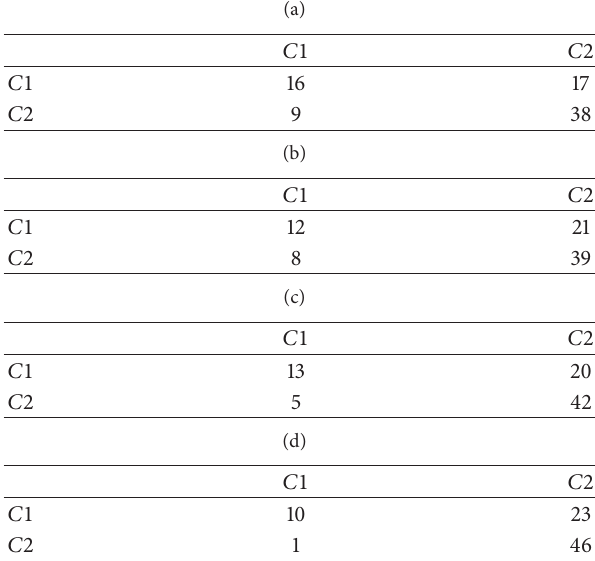
Table 11:Confusionmatrices of(a)Adaboost, (b)Bagging, (c)RSM, and (d) proposed approach using German